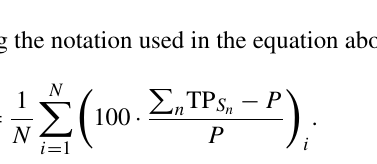
Figure 4. Total monthly accumulated tracer precipitation (mm) from lake evaporation (a) , sea evaporation (b) , land evapotranspiration (c) , lateral boundary advection (d) and initial moisture (e) , and the sum of all contributions (f)